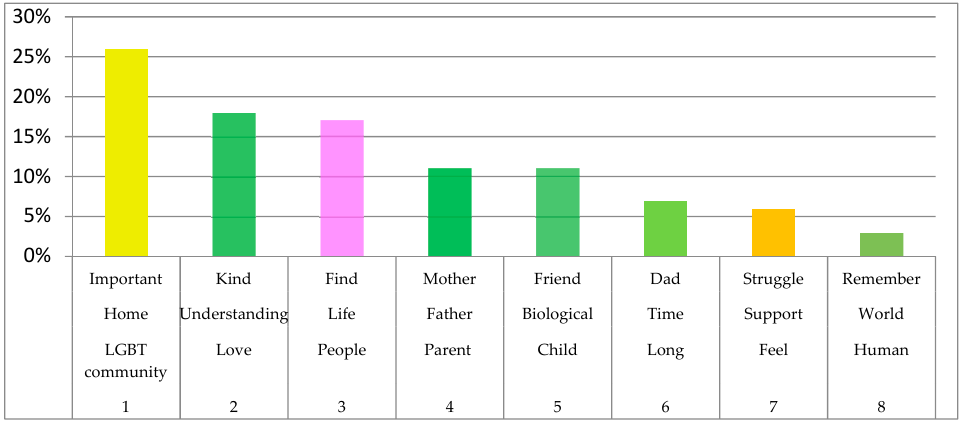
Figure 2. Main topical groups.